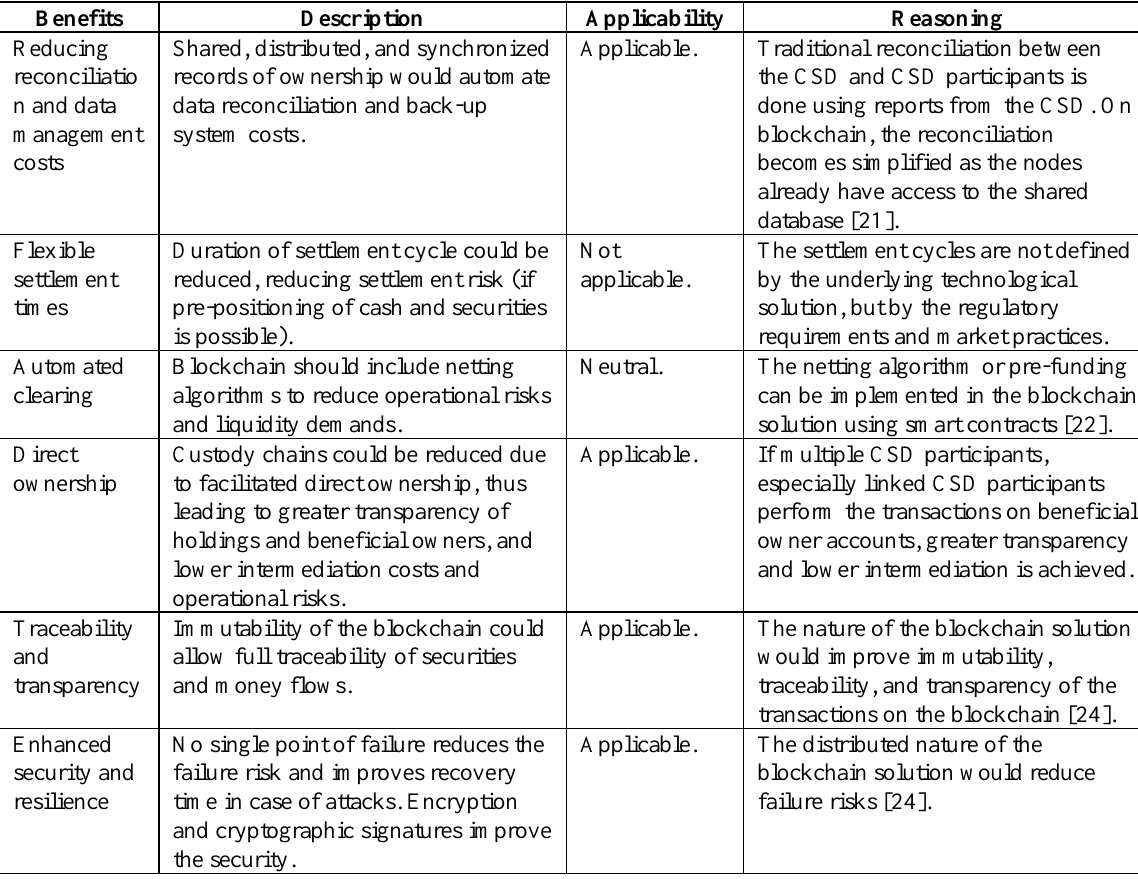
Table 7. Evaluation of benefits of the proposed blockchain architecture model and node